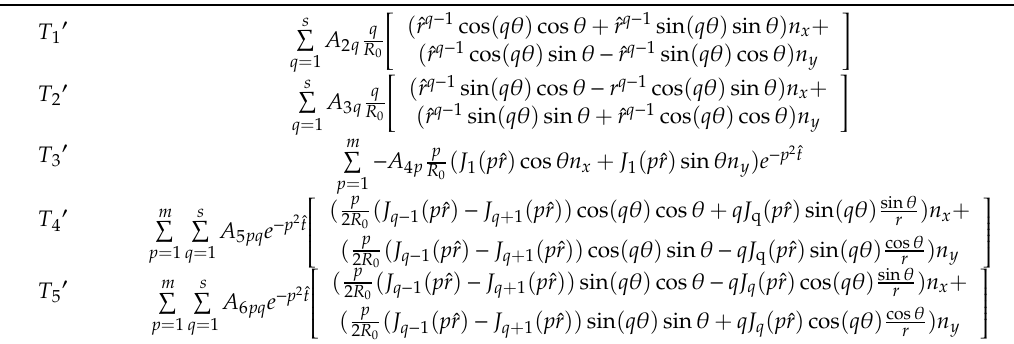
Table 1. The notation in Equation (15).